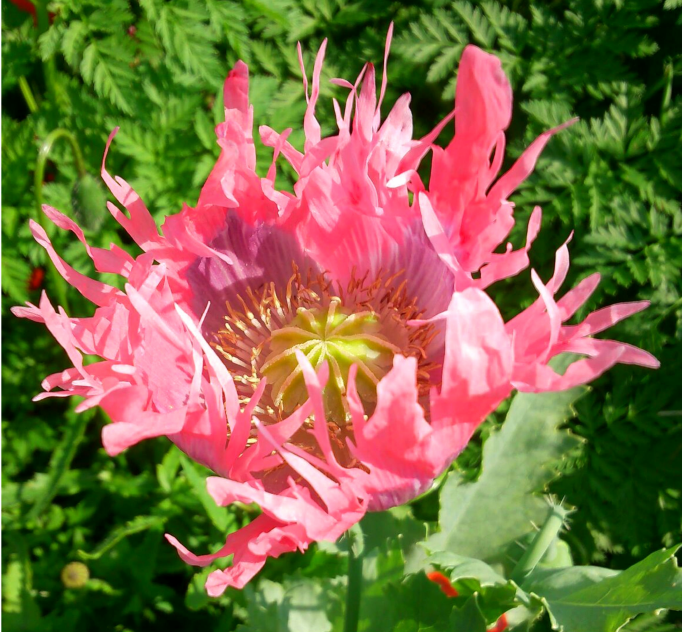
Figure 61. Papaver somniferum in Caffarella